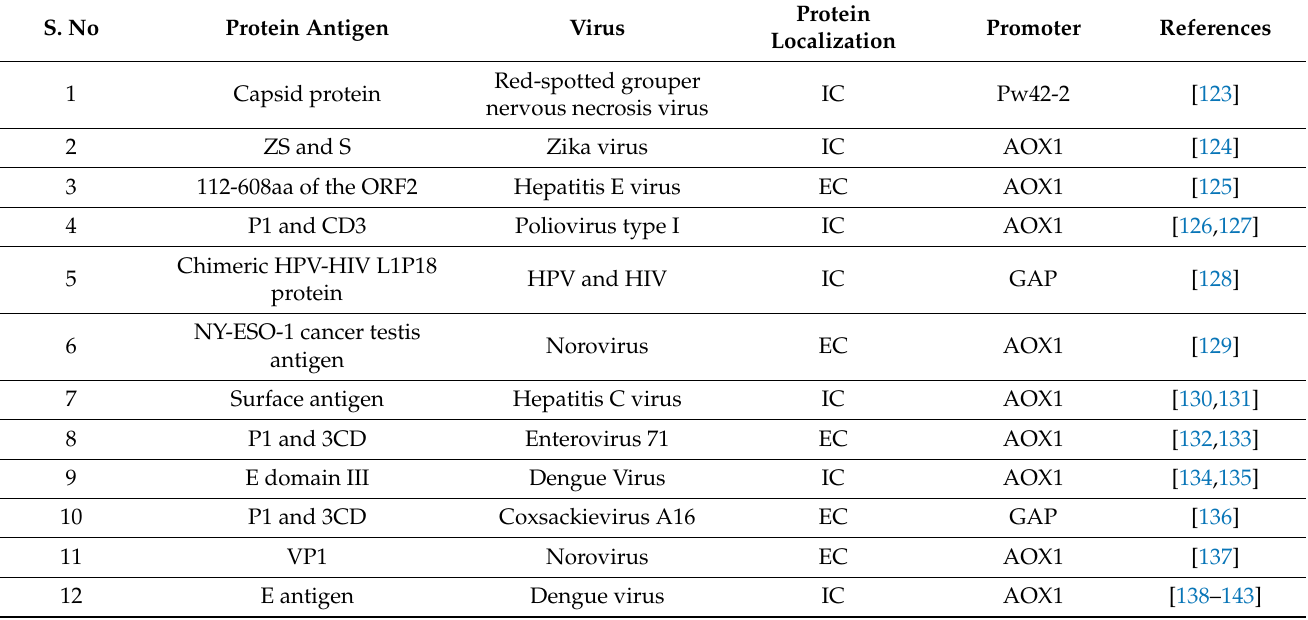
Table 3. Studies where K. phaffii yeast was used to generate